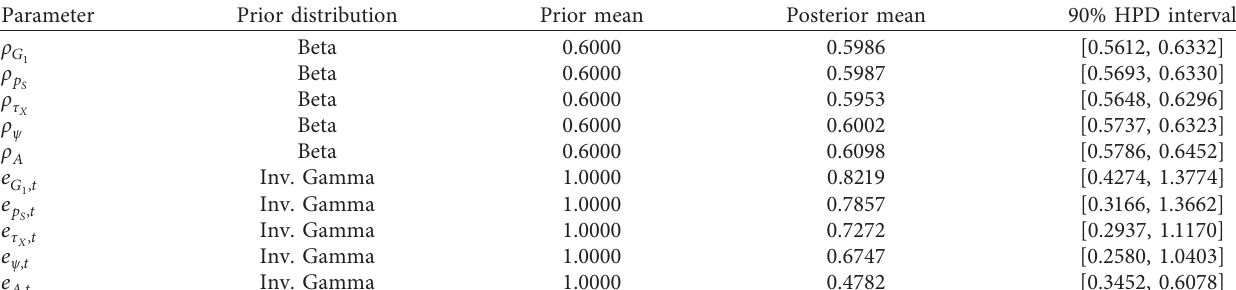
Table 2: Bayesian estimation results of dynamic parameters.